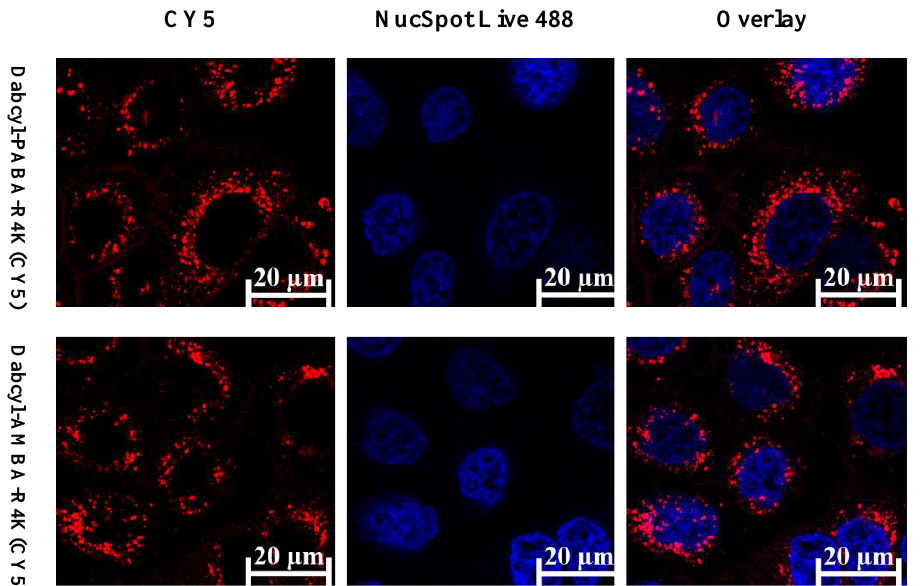
Figure 6. Cellular distribution of peptides on SCC-25 cells visualized by confocal microscopy. Cells were incubated with the CY5-labelled peptides for 1hr (Red) at 5 µM. Nuclei were stained with NucSpot Live 488 (blue). Imaging was performed by a Zeiss LSM 710 system.